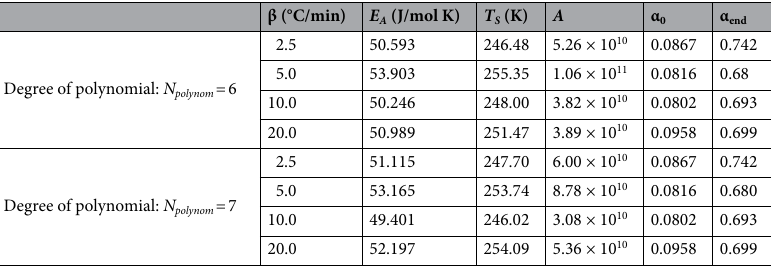
Table 1. Numerical values of kinetic parameters determined by the new